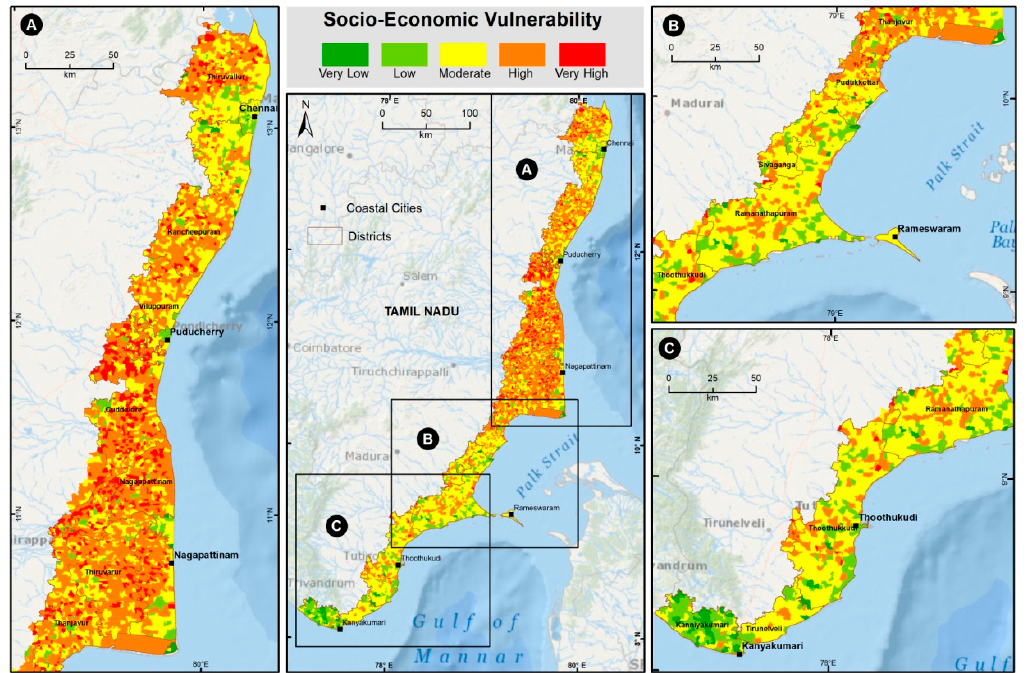
Figure 7. Spatial distribution of composite socio-economic vulnerability in the coastal plains of Tamil Nadu (modified from Balasubramani et al., 2021). The distributions of socio-economic vulnerability in the northern, central, and southern parts of the coastal plains of Tamil Nadu are represented in inset figures ( A – C ),